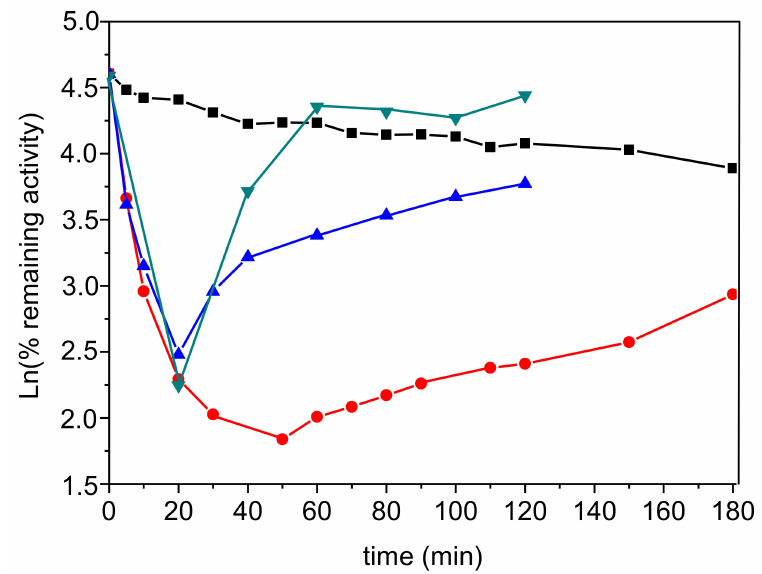
Figure 6. SBI and subsequent acylation of 2 × 10 − 9 M AChE by 2 × 10 − 8 M TFK, followed by slow deacylation. Activity was assayed with 1 mM ATC with DTNB as the thiol probe (black, blue, red curves) and with Probe IV as the thiol probe (green curve). The black curve is enzyme activity (control) in the presence of 2% acetonitrile; the red curve is enzyme activity monitored up to 180 min in the presence of 2 × 10 − 8 M TFK. Blue curve: after steady-state SBI, the system was diluted 10 times, so that TFK dropped to 2 × 10 − 9 M after t = 20 min. Green curve: after steady-state SBI, the system was diluted 1000 times, then TFK final concentration dropped to 2 × 10 − 11 M after t = 20 min. The first-order rate constant of deacylation ( k reac ) was estimated from the slope of Ln increase in activity vs. time. The slow recovery of enzyme activity depends on the TFK concentration present in the medium. In the presence of remaining 0.02 nM TFK (green curve), it takes less than 40 min to regain an activity similar to that of control enzyme at t = 60